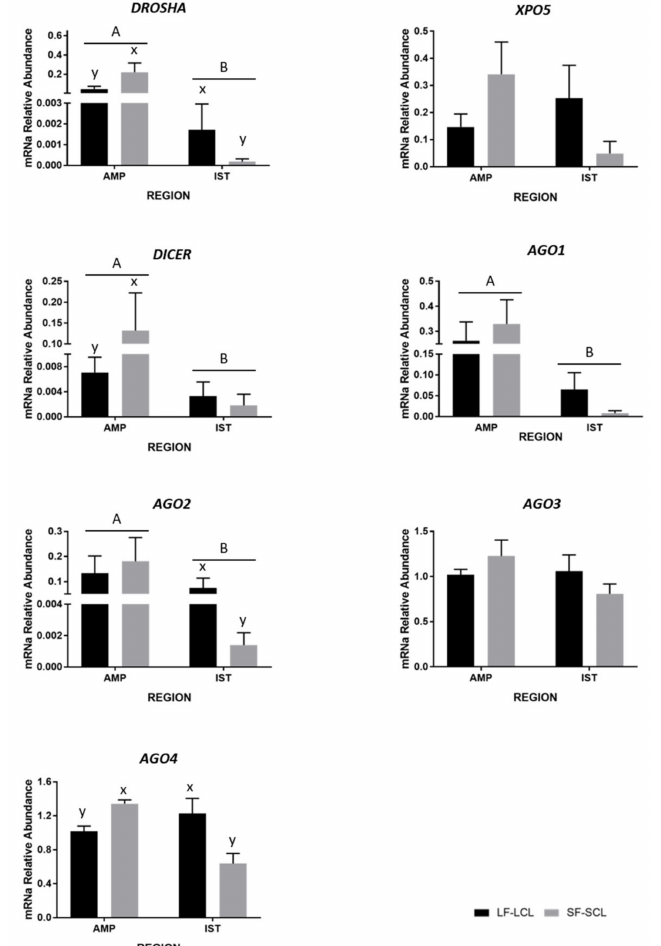
Figure 1. Relative levels of miRNA processing pathway-components. Mean ± SEM. Transcript abundance ( n = 6 per group) of genes involved in the miRNA biosynthetic machinery, expression normalized to peptidylprolyl isomerase A (PPIA) and glyceraldehyde 3-phosphate dehydrogenase (GAPDH) in the ampulla (AMP) and isthmus (IST) ipsilateral to the CL from beef cows synchronized to ovulate a large (LF-LCL) or a small follicle (SF-SCL). Oviductal tissue samples were collected on day 4 of the estrous cycle. Differences between groups (x or y) and regions (A or B) are indicated when p value ≤ 0.05. Genes: Drosha ribonuclease III (DROSHA), Exportin 5 (XPO5), Dicer 1 ribonuclease III (DICER), RISC catalytic components: Argonaute 1, 2, 3, and 4 (AGO1, AGO2, AGO3,